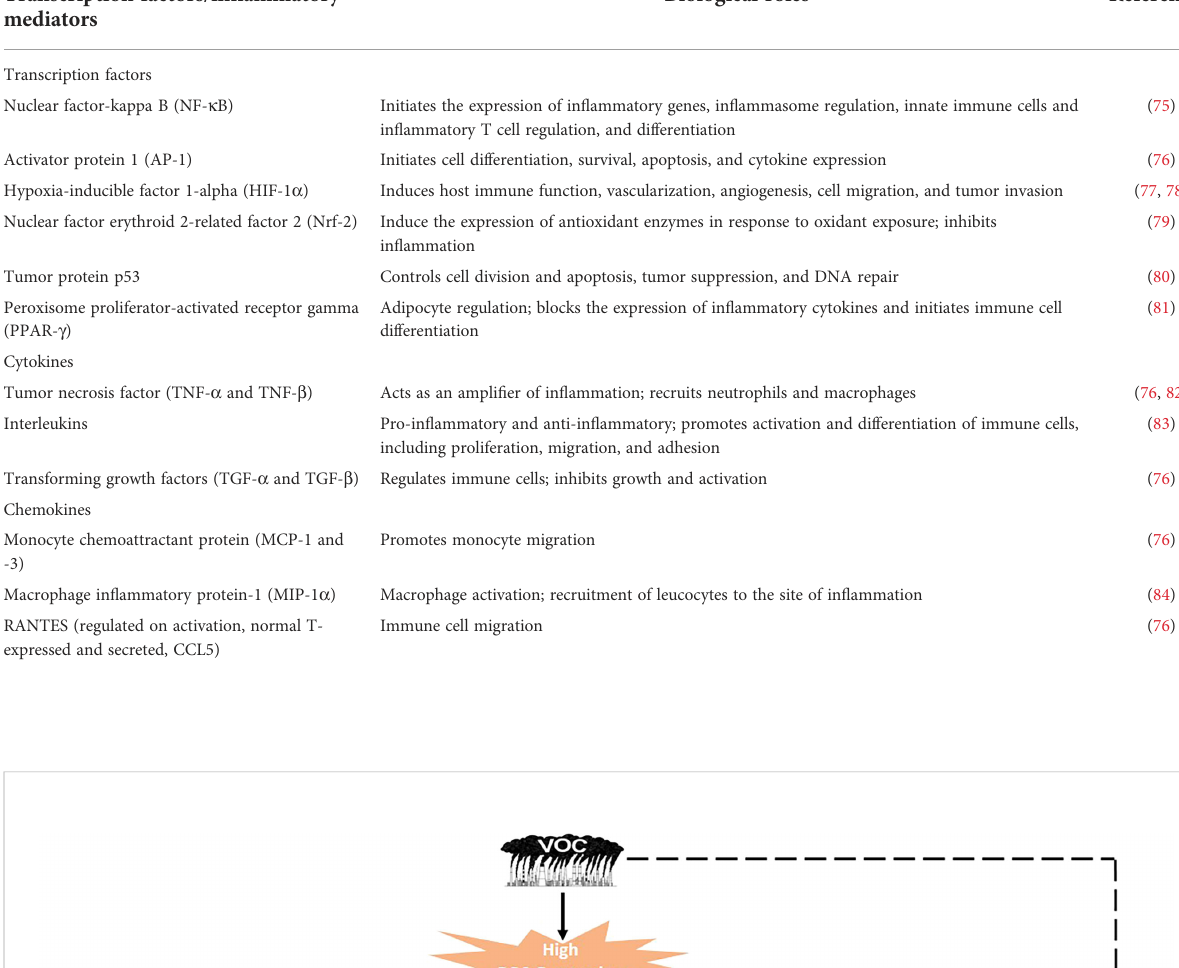
TABLE 2 Transcription factors and in fl ammatory mediators involved in in fl ammation and oxidative stress.